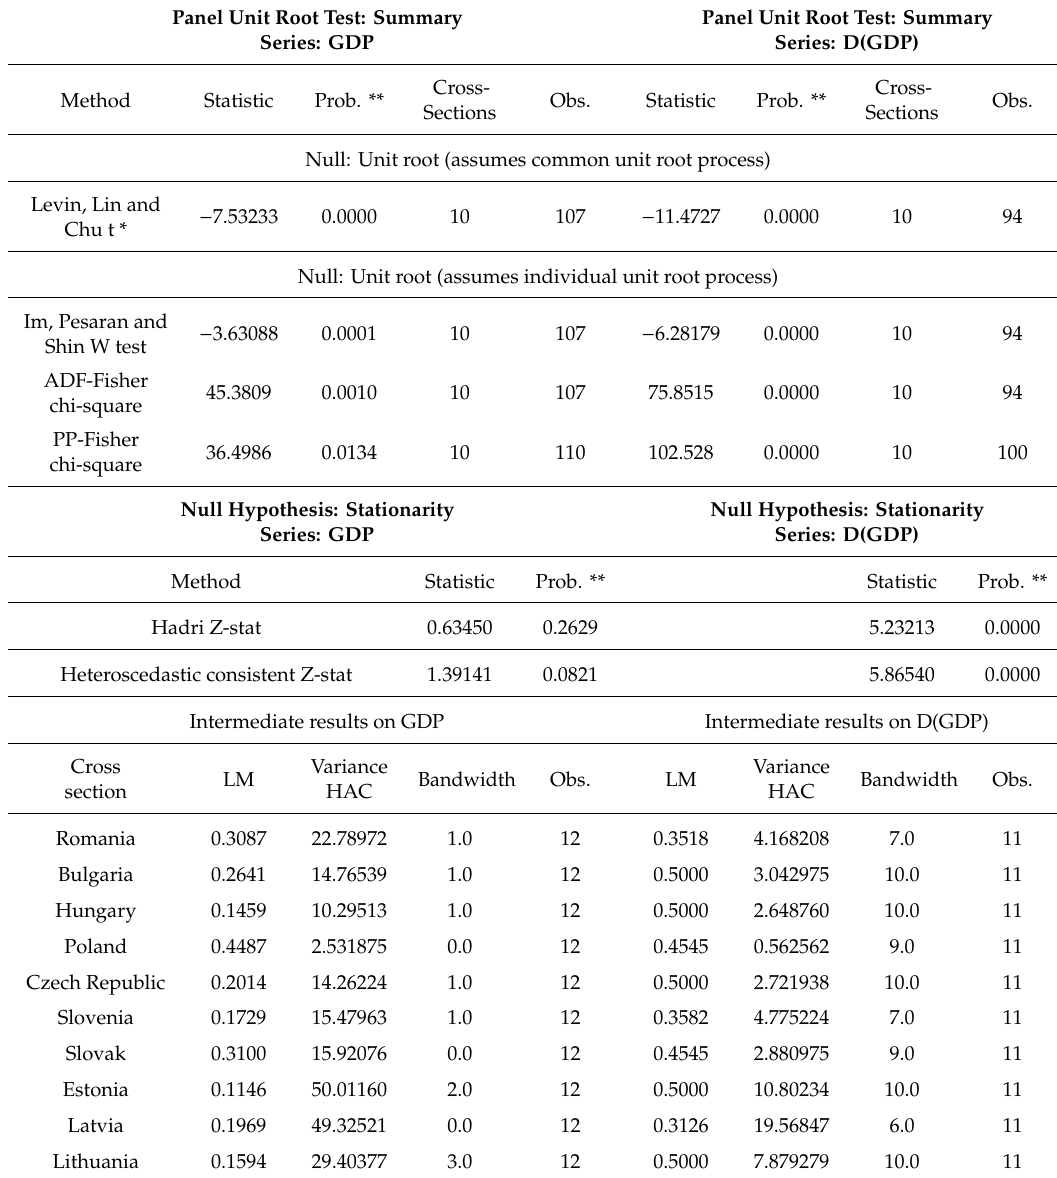
Table 3. Unit Root Test and Hadri